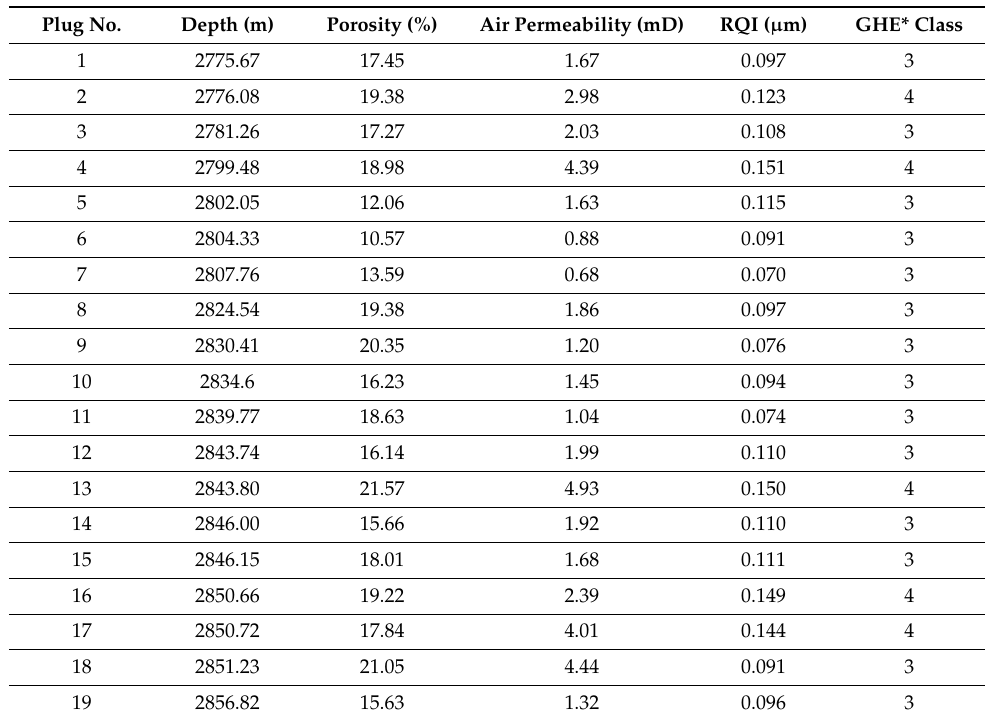
Table 1. Characteristics of the rock samples used in the